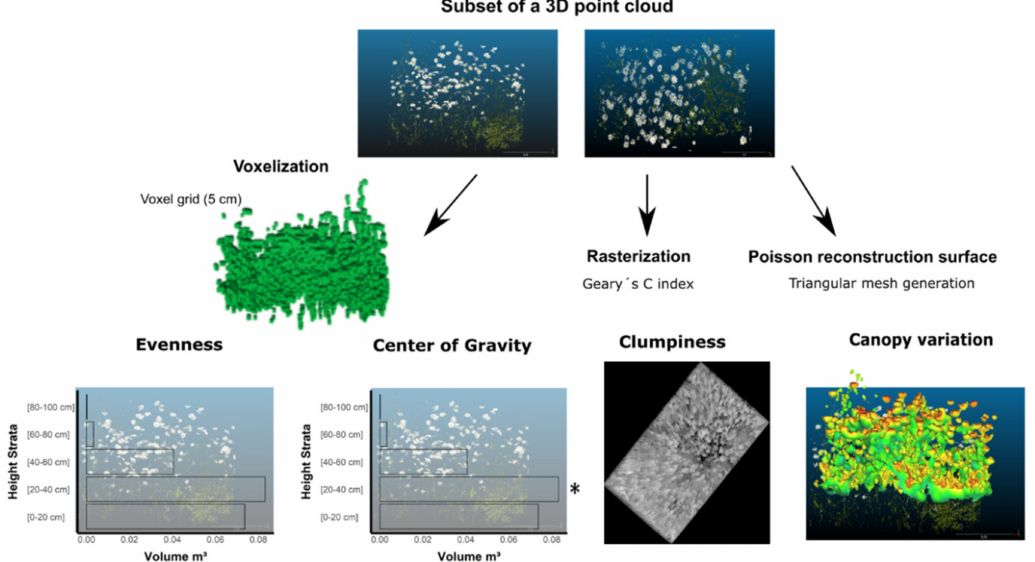
Figure 1. Visualization of the canopy structural component metrics using a subset of 3D point clouds of a sampling plot in which we calculated volume based on voxel grids with a resolution size of 5 cm. The volume is distributed in 5 height strata varying from (1: 0.3–20 cm, 2: 20–40 cm, 3: 40–60 cm, 4: 60–80 cm, and 5: 80–100 cm) and used to measure evenness and center of gravity indicated by the *. Further, the 3D point clouds were rasterized to calculate Geary’s C index (clumpiness); and using Poisson reconstruction surface of canopy surface, we calculate canopy variation by dividing the canopy surface area by the area of the ground plot. More details described in Methods the section about canopy structural